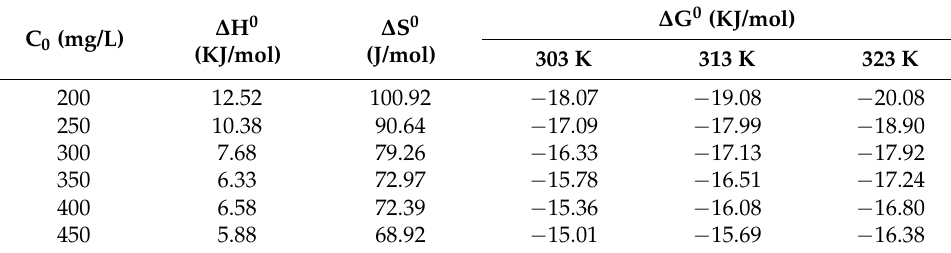
Table 8. Thermodynamic parameters for Cu 2+ adsorption. The calculated thermodynamic parameters of Cu 2+ and Zn 2+ were listed in Tables 8